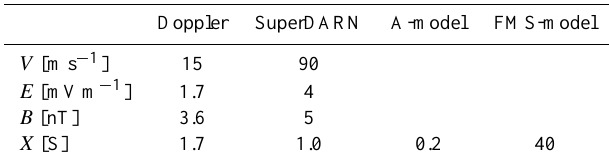
Table 1. Mid-latitude ( 8 ∼ 50 ◦ ) Pi2